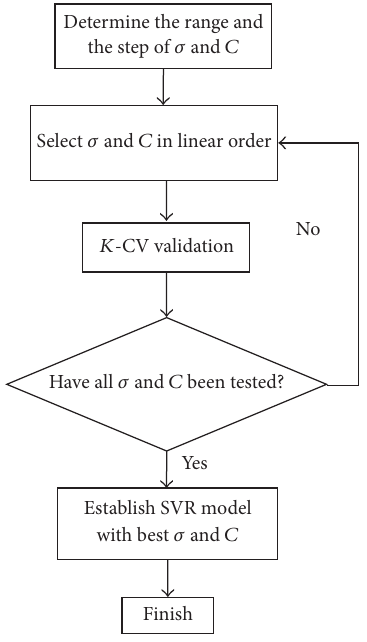
Figure 3: Flow diagram for the optimization of SVR